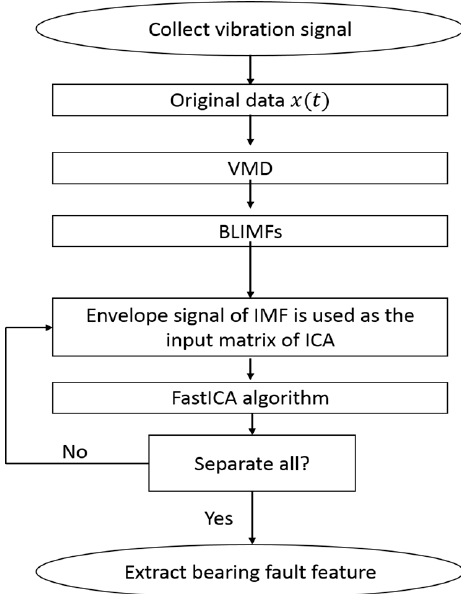
Figure 2. Detailed experimental scheme. BLIMF, band-limited intrinsic mode function; IMF, intrinsic mode function.